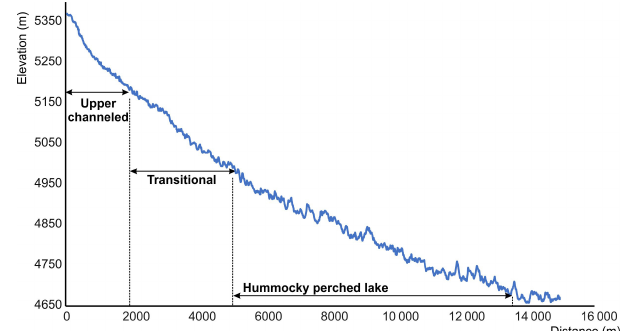
Figure 2. Longitudinal surface profile of the W branch and main trunk of Ngozumpa Glacier, showing downglacier changes in gradi- ent and relative relief (see Fig. 3a for location). “Upper channeled”, “transitional”, and “hummocky perched lake” refer to the drainage zones described in Sects. 4.2 and 4.3.